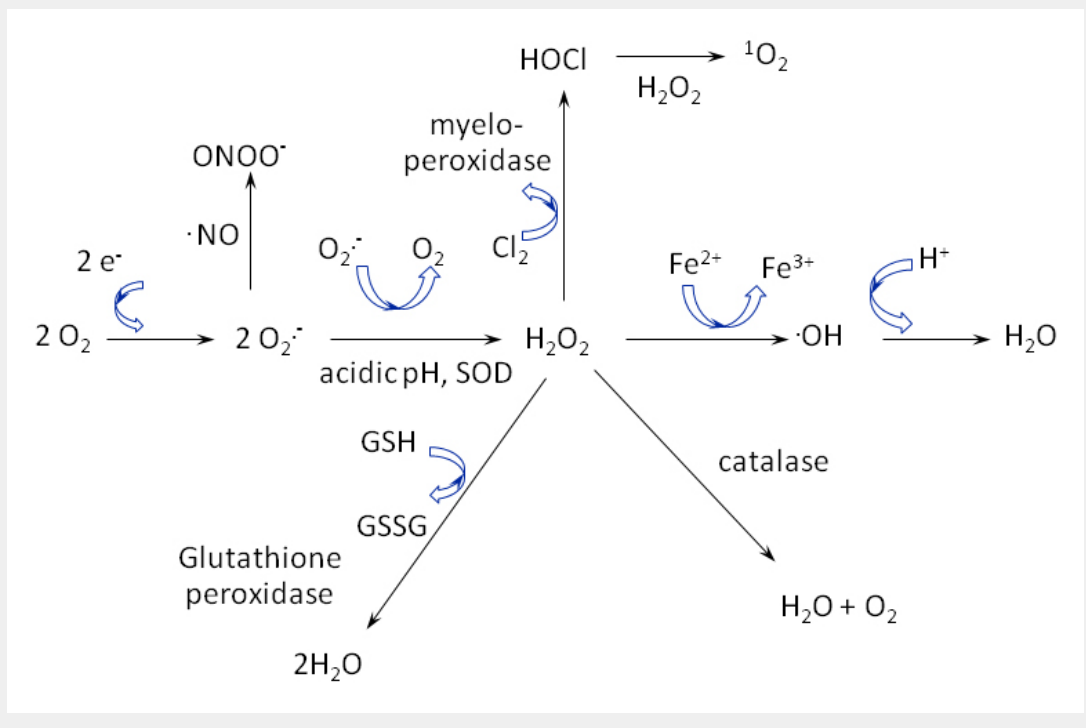
Figure 2 ROS are highly reactive and quickly transition between species. Notably, the superoxide anion (O 2.- ) is unstable and quickly dismutates, by action of superoxide dismutase (SOD), into hydrogen peroxide (H 2 O 2 ). If the anion reacts with nitric oxide ( . NO), then peroxynitrite (ONOO - ) is formed. Singlet oxygen ( 1 O 2 ) is formed upon the reaction of hypochlorous acid (HOCl) with hydrogen